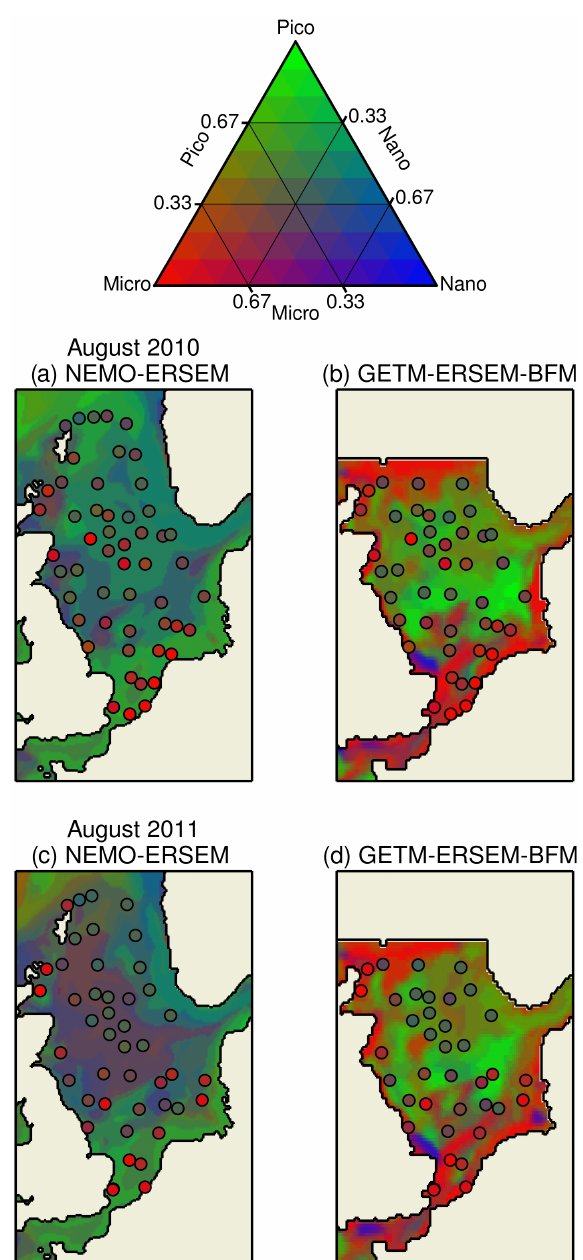
Figure 14. Maps of modelled surface phytoplankton community structure for August 2010 (a, b) and August 2011 (c, d) from NEMO-ERSEM (a, c) and GETM-ERSEM-BFM (b, d) . The IBTS observations, sampled in August and early September of each year, are overlaid in